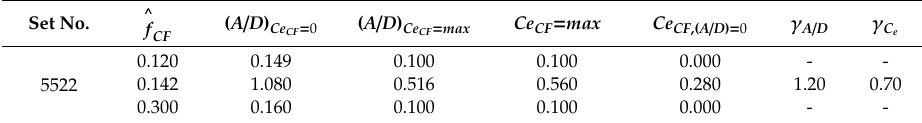
Table 10. Optimal excitation coe ffi cient parameters with modification factors for buoyancy part. Set